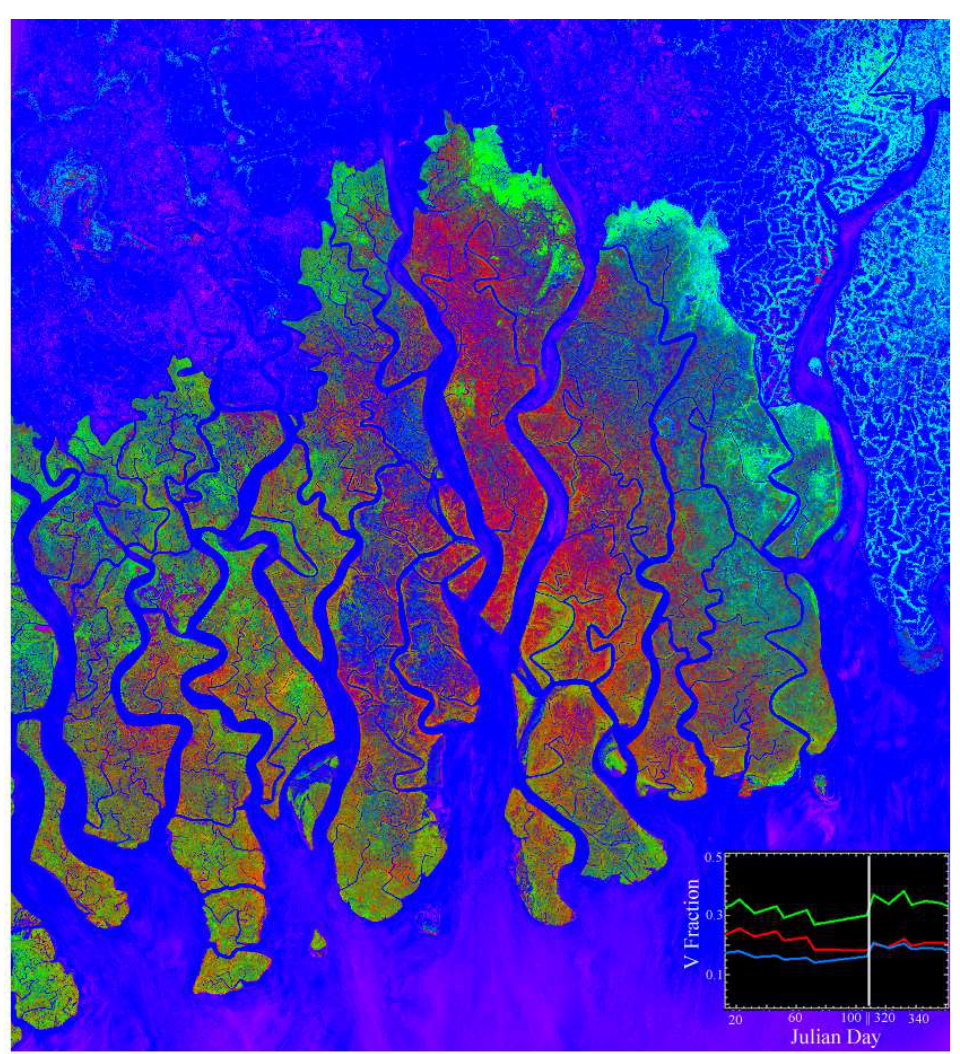
Figure 7. Temporal mixture model fraction map for HLS Low Rank image time series. Inset temporal EMs correspond to apexes of the mangrove cluster in the PC1 / 2 temporal feature space shown in Figure 6. Water and agricultural areas appear blue and magenta because they lie outside the model but closest to the blue EM. Note qualitative spatial similarity to the tri-temporal fraction map in Figure 4. The red EM shows a decrease in greenness preceding the monsoon, but little increase after.